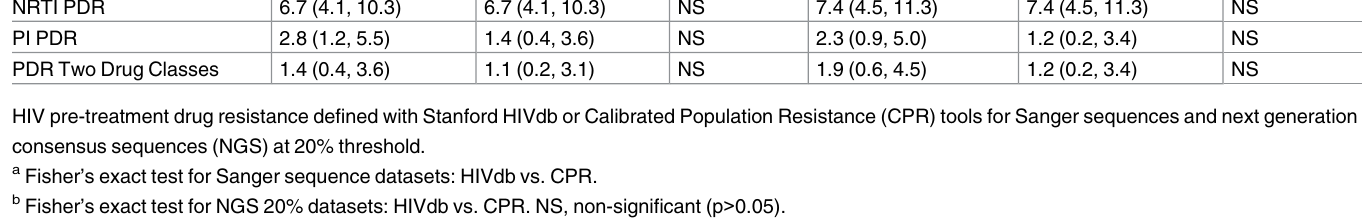
Table 2. HIV pre-treatment drug resistancein Nicaragua. HIVdb Sanger CPR Sanger